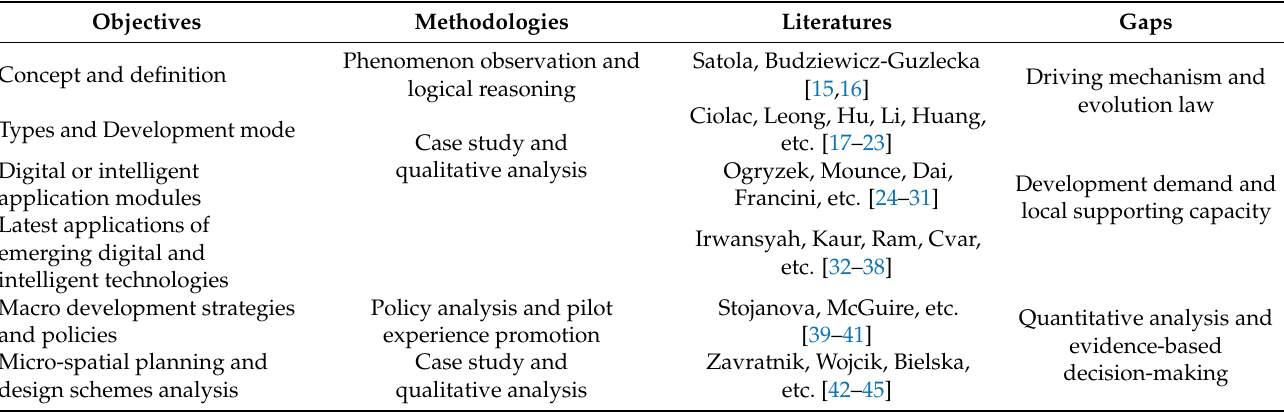
Table 1. Literature review and research gaps